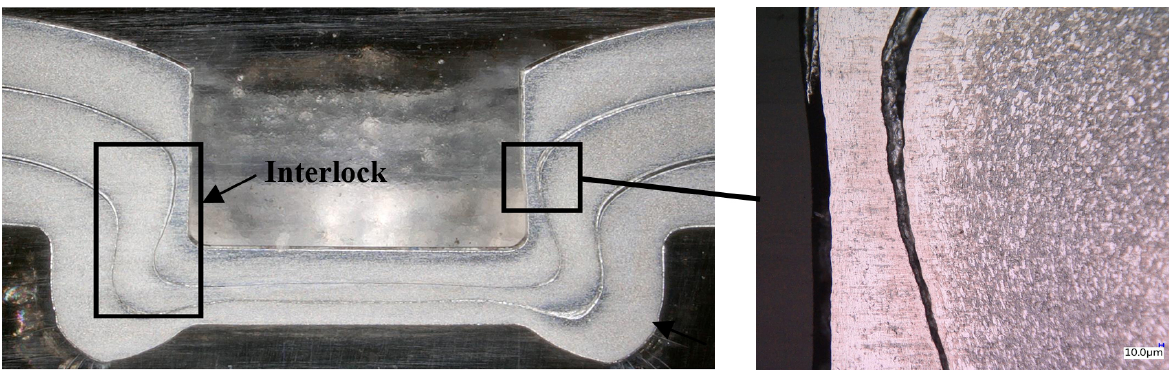
Figure 10: Areas of interlocking of clinched joints with DX53 steel sheet.